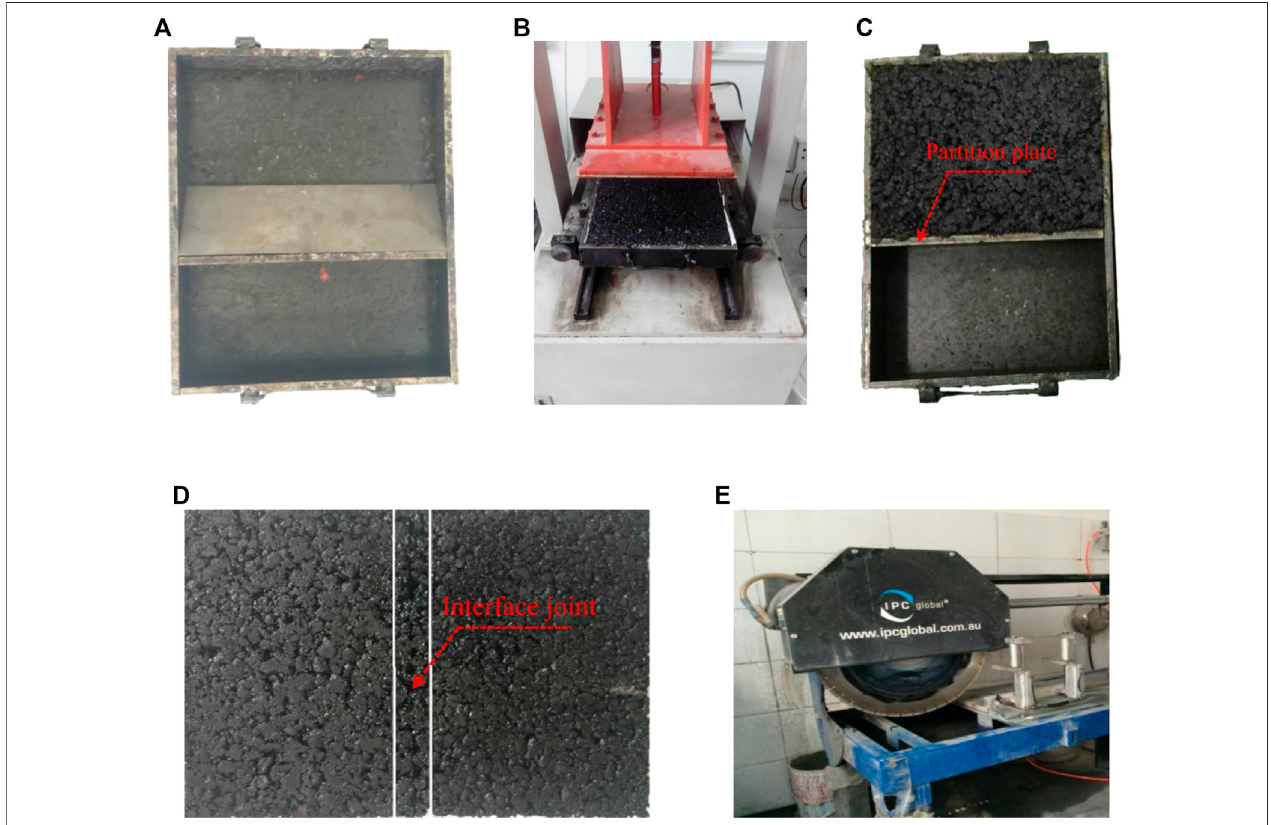
FIGURE1| Theprocedureofspecimenfabrication: (A) steelmoldwithdividingplate; (B) mixturecompaction; (C) halfslabformation; (D) thewholeslabformation; (E) specimen cutting.